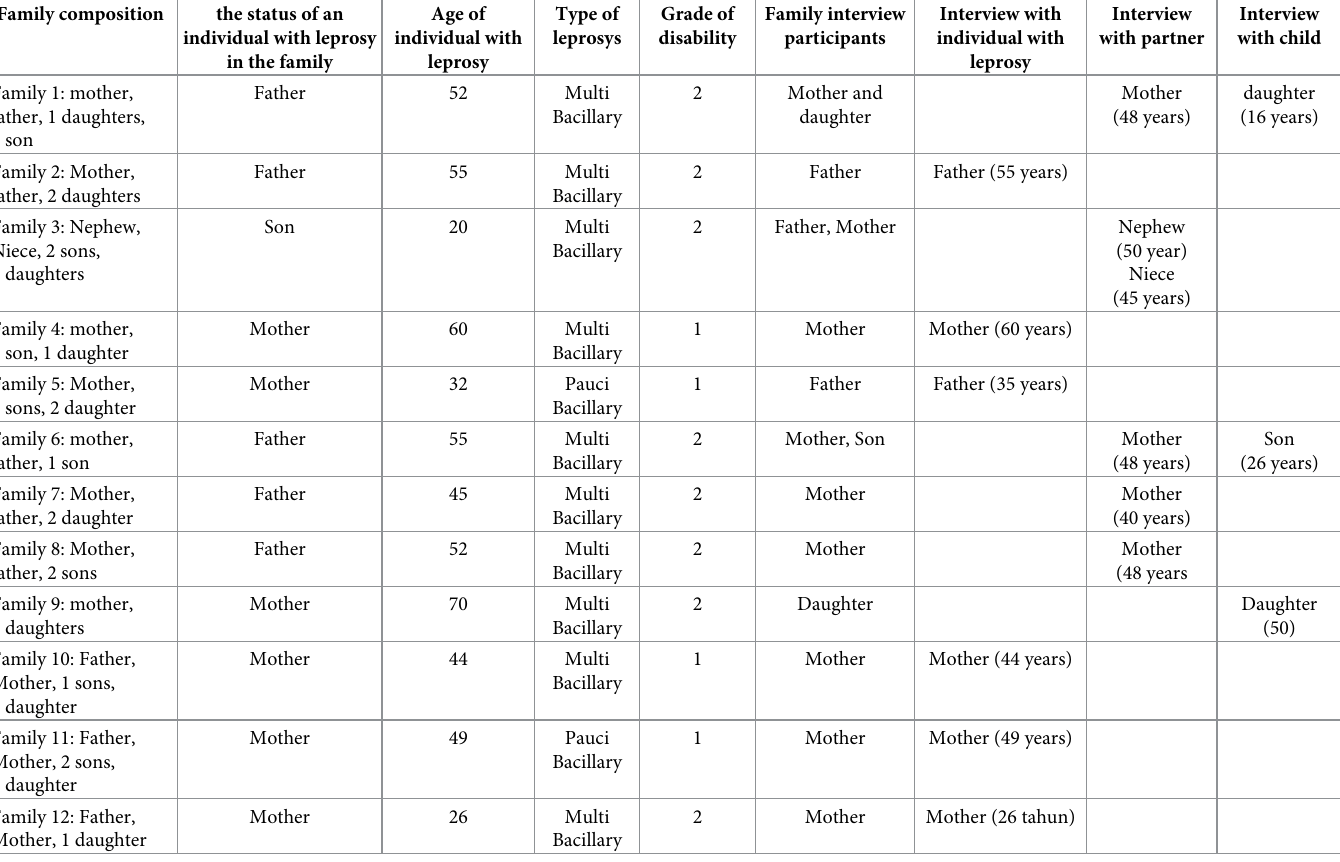
Table 3. Family members and their participation in the